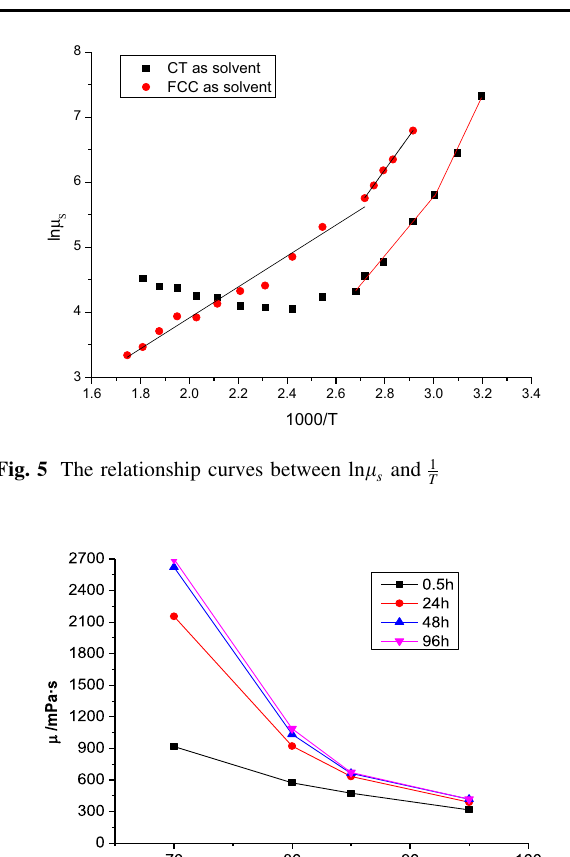
Fig. 6 Viscosity of coal–oil slurry under different swelling